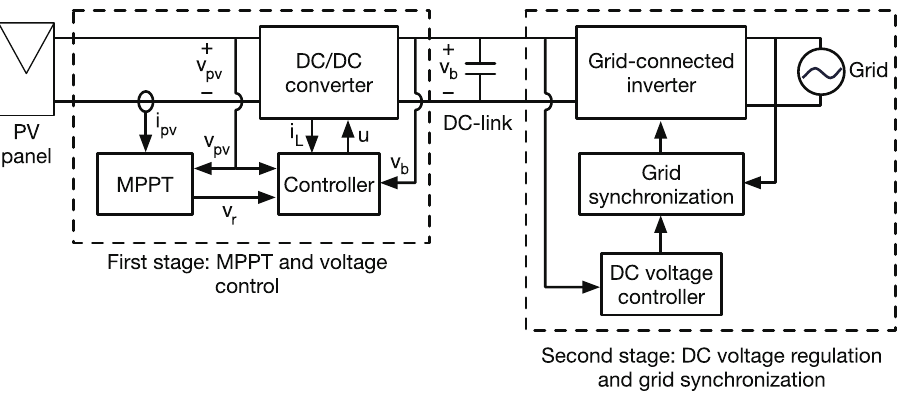
Figure 1. Structure of a PV microinverter with DC-link regulation and grid